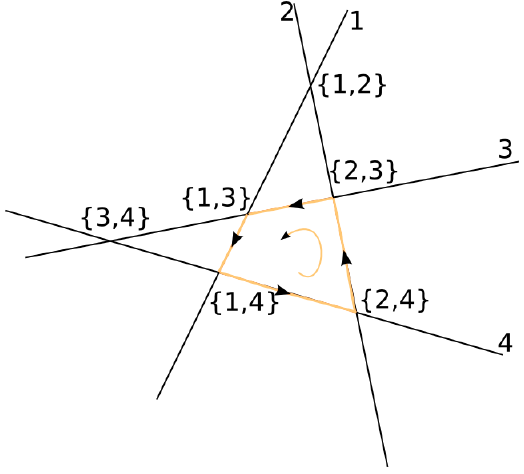
Figure 4 . The quadrilateral corresponding to the list l = (1 ; 4 ; 2 ;